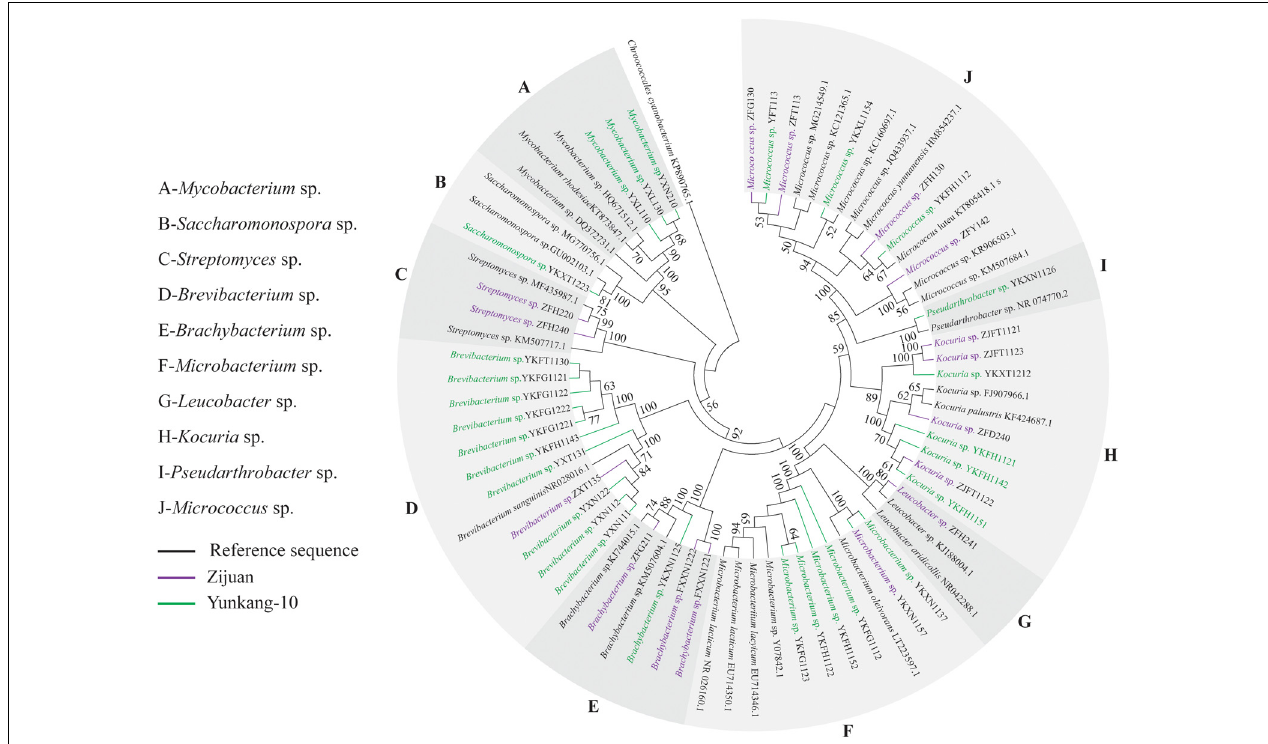
FIGURE 1 | Phylogenetic analysis of endophytic actinobacteria in different seasons from Zijuan and Yunkang-10. The phylogenetic tree was constructed by using 73 16S rRNA gene sequences.